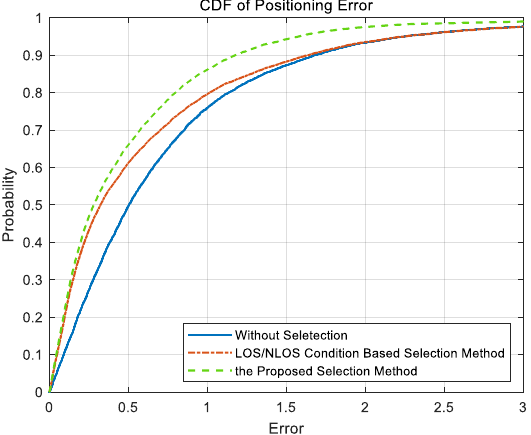
ff erent BS selection